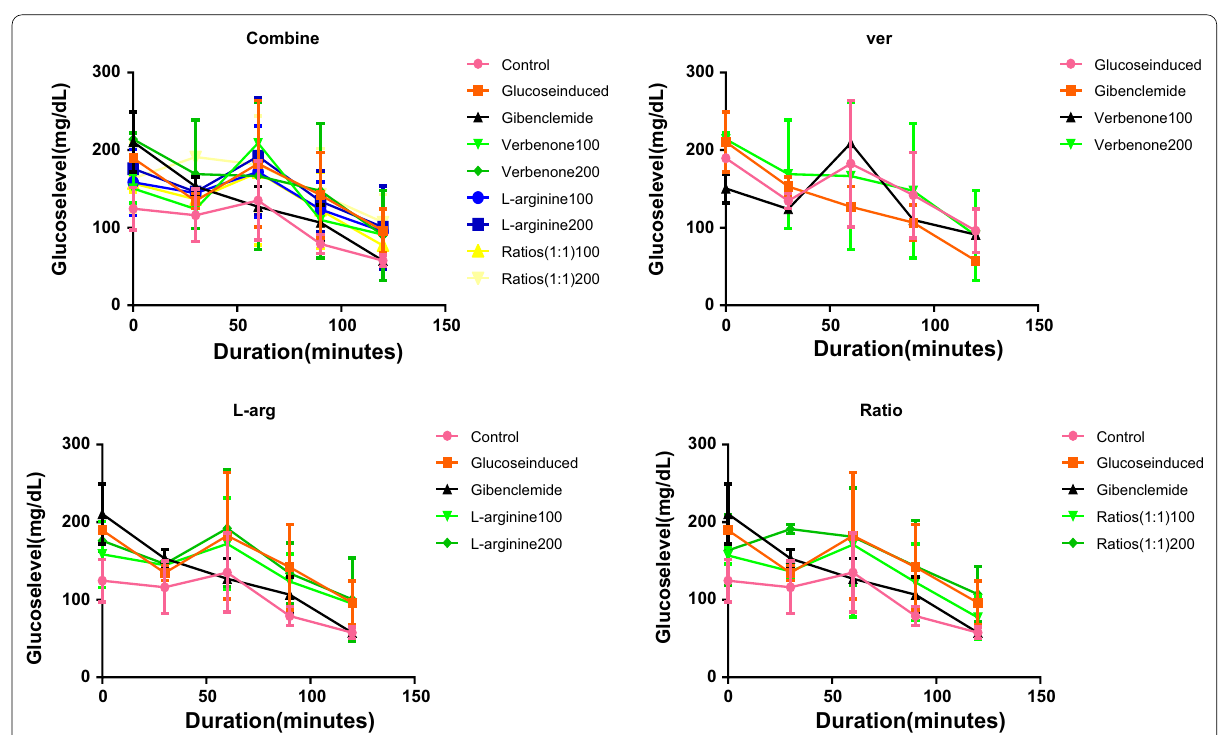
Fig. 6 Oral glucose tolerance test for verbenone, L-arginine and ratios of verbenone determinations. Ratios (1:1)